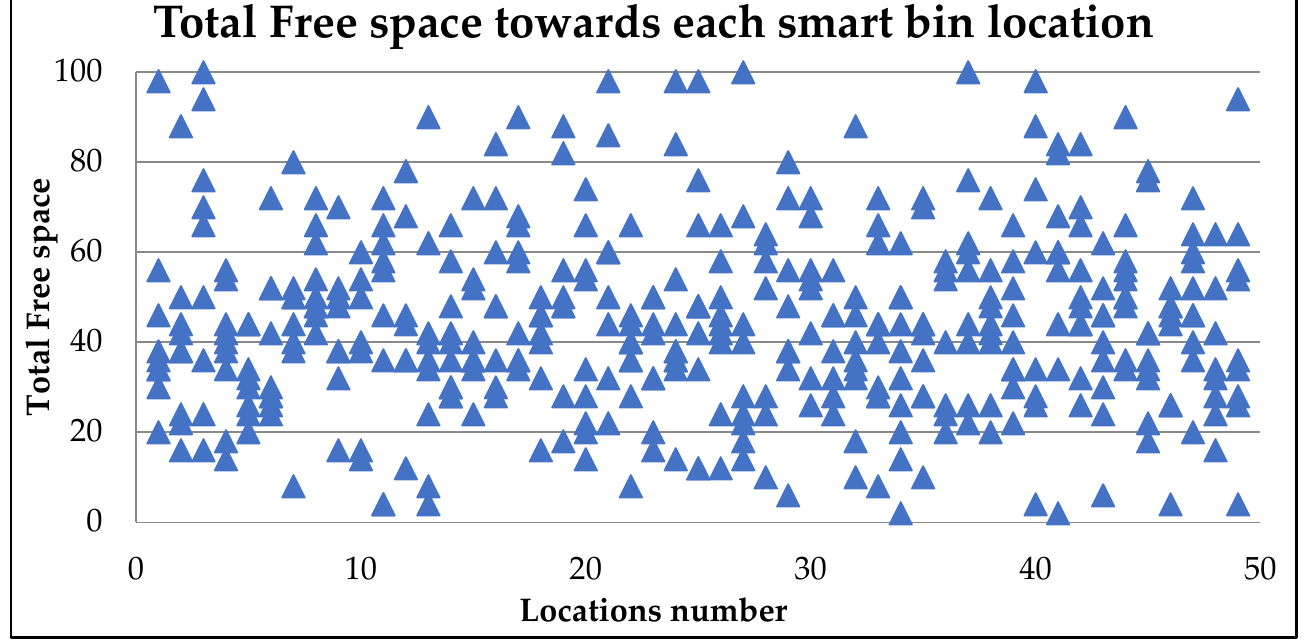
Figure 17. Possible routes between all locations.